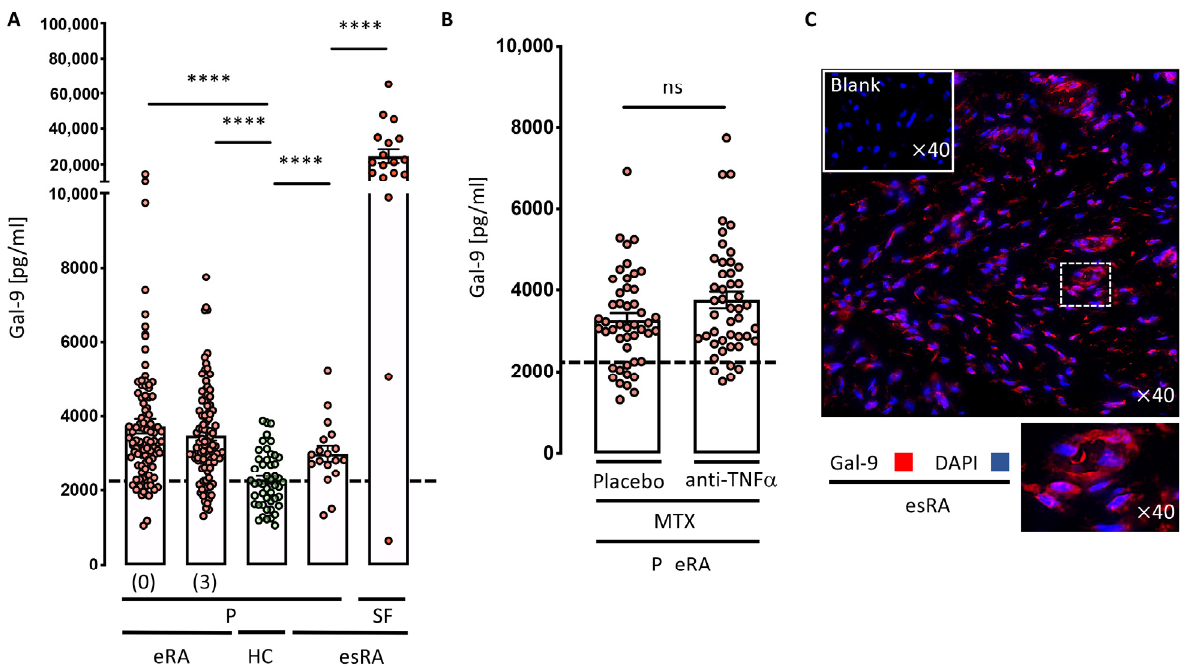
Figure 1. Gal-9 levels in plasma (P) or synovial fluid (SF). ( A ) Samples from 98 early RA (eRA) patients were analyzed at baseline (0) or after 3 months treatment (3) and compared to 48 healthy controls (HC). Paired samples of plasma and SF from 18 established RA (esRA) patients were also analyzed. Dashed line represents mean HC Gal-9 levels. ( B ) Gal-9 levels in plasma after 3 months of the two treatment regimens (MTX + placebo, n = 50) and (MTX + anti-TNF, n = 48). Dashed line represents mean HC Gal-9 levels. ( C ) Representative synovial tissue expression of Gal-9 and DAPI ( n = 6). Differences were analyzed using the either paired or unpaired t- tests to compare two groups. Bars indicate Mean ± SEM. **** p < 0.0001. ns: not significant.